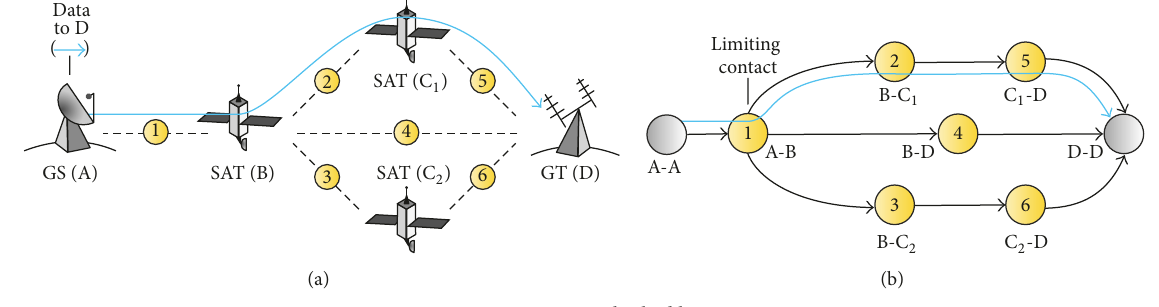
Figure 8: Routes overlooked by